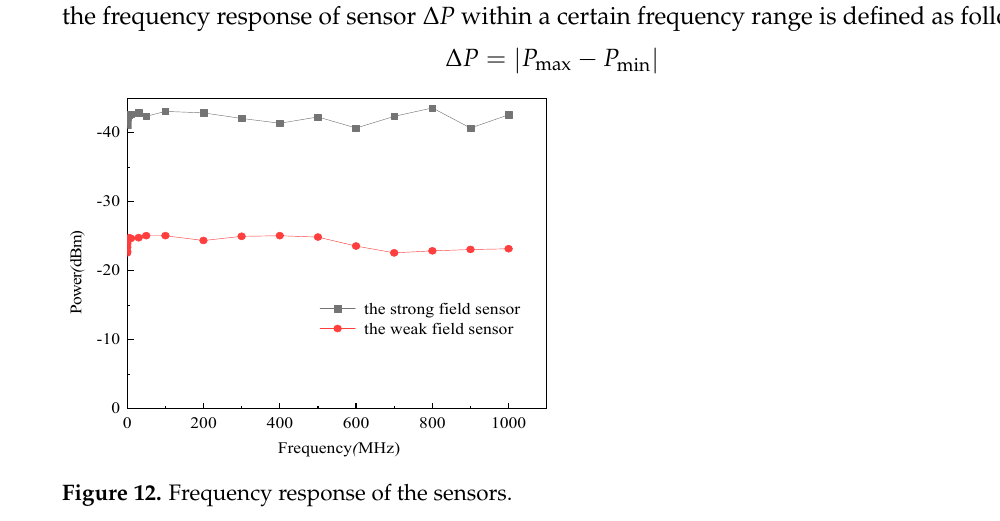
Figure 13. The time domain test configuration diagram of the weak field strength test ( a ) and strong field strength test ( b ).